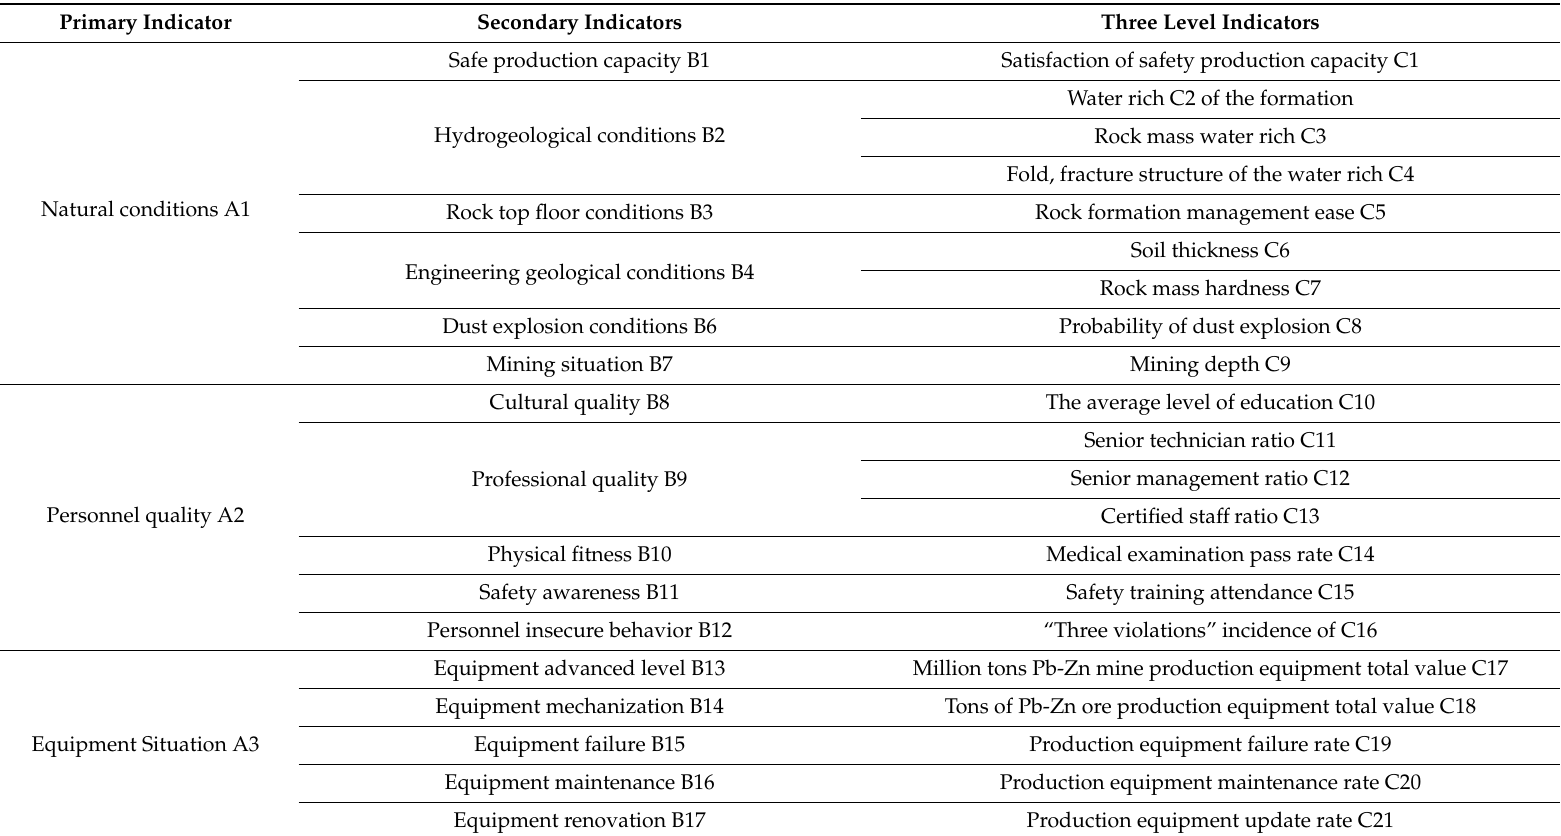
Table 1. Pb-Zn mine safety indicators’ evaluation